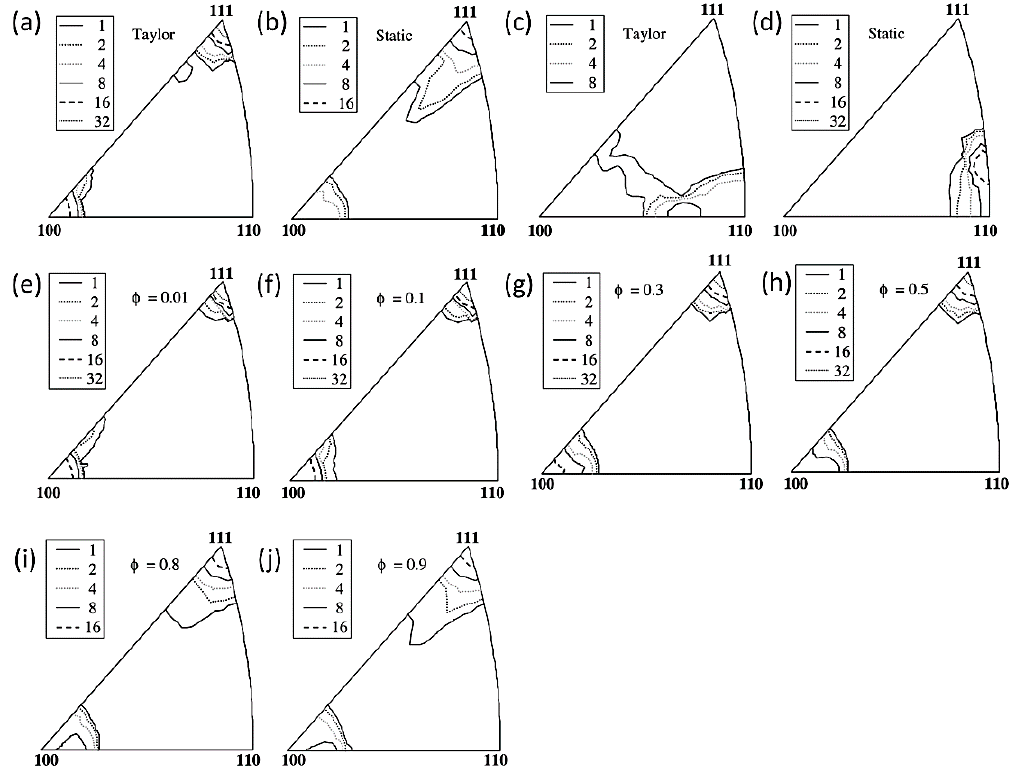
Figure 5. ( a , b ) Inverse pole figures in the case of Taylor ( ϕ = 0) and Static models ( ϕ = 1) at strain ε = 100% for tensile test; ( c , d ) inverse pole figures in the case of Taylor ( ϕ = 0) and Static models ( ϕ = 1) at strain ε = 100% for compression test; ( e – j ) inverse pole figures for tensile test at ε = 100% for the ϕ model (texture evolution for ϕ = 0.01 close to Taylor, 0.1, 0.3, 0.5, 0.8, and 0.9 close to Static for a strain level of 100% for axisymmetric tensile).